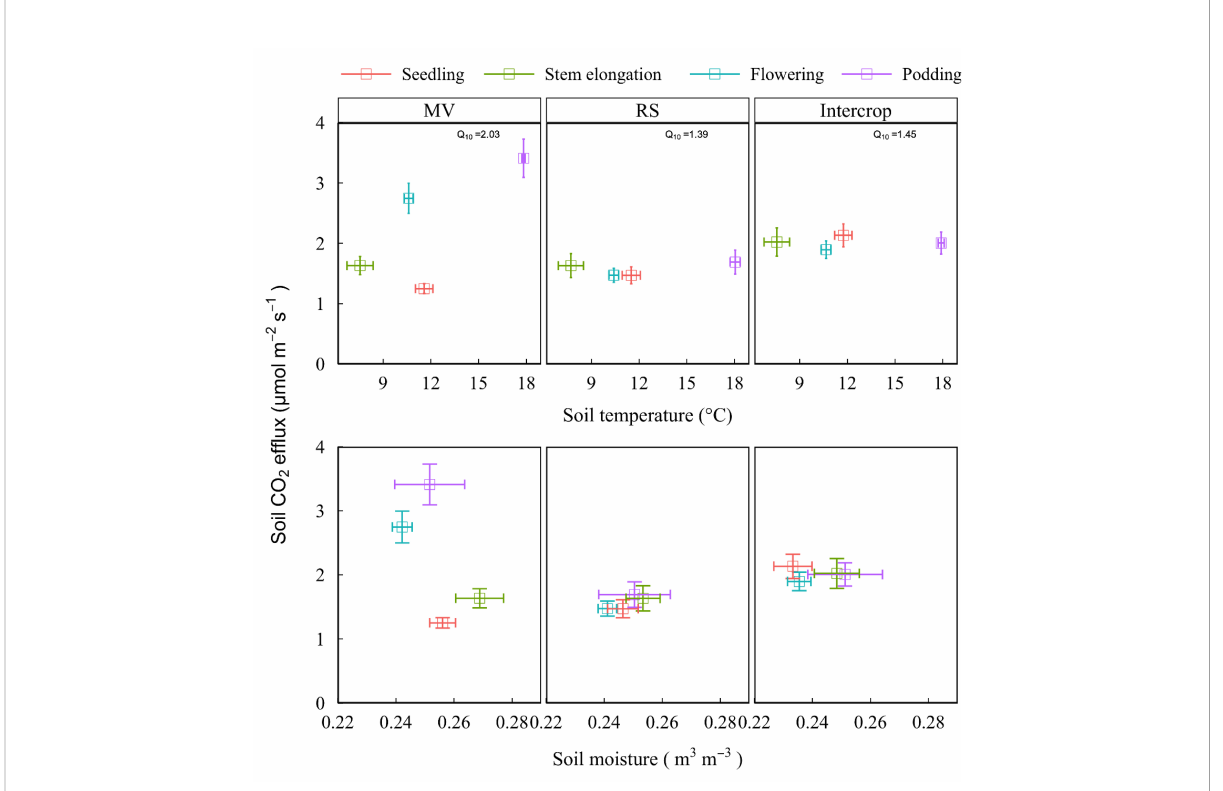
FIGURE 6 Soil respiration and hydrothermal factor under various crop systems and plant growth stages. Data shows means and standard errors. Q 10 value is the sensitivity of soil respiration to temperature change, which was calculated as y=ae bx , Q 10 = e 10b , where y is the soil respirartion, and x is temperature, a and b are fi ited